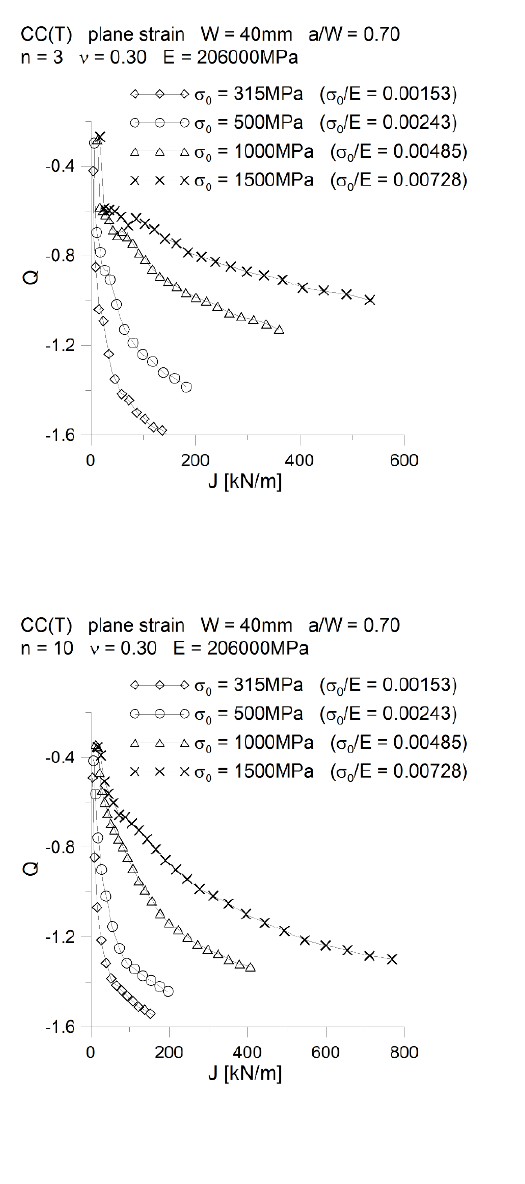
Figure 20. The influence of the yield stress on J - Q trajectories for CC(T) specimens with crack length a / W =0.70 for different power exponents in R-O relationship: a) n =3; b) n =5; c) n =10; d) n